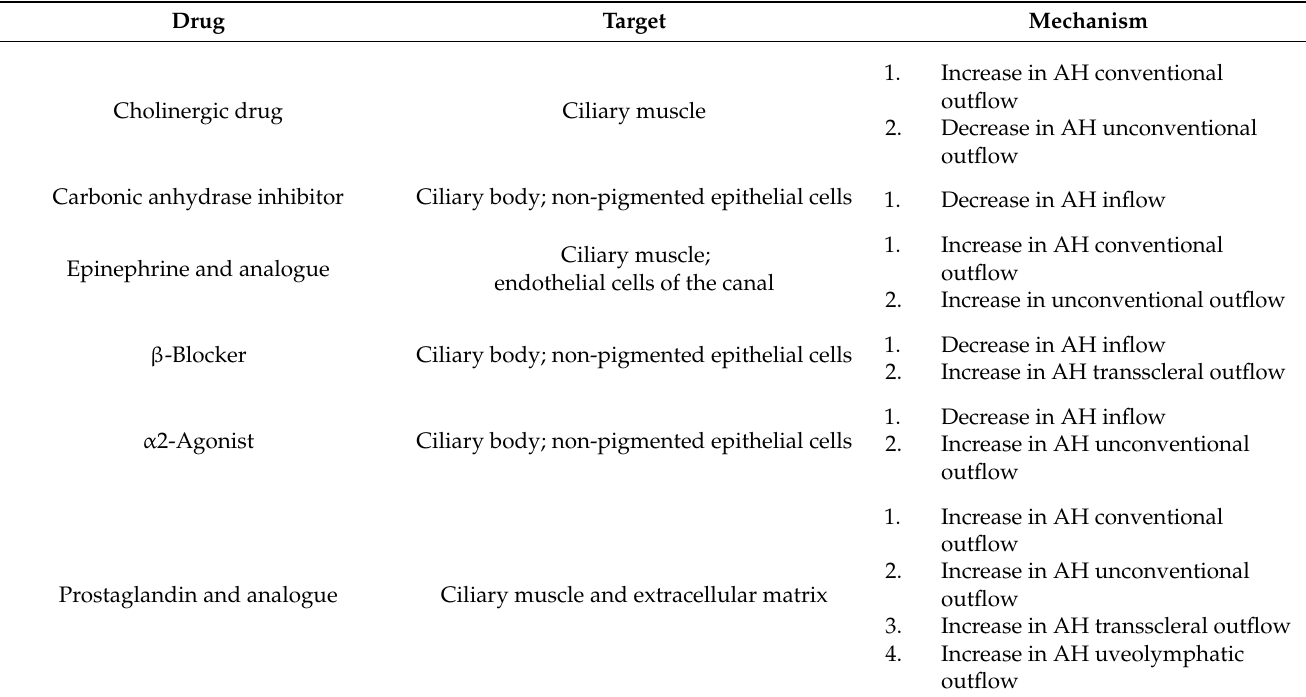
Table 2. Drugs and related